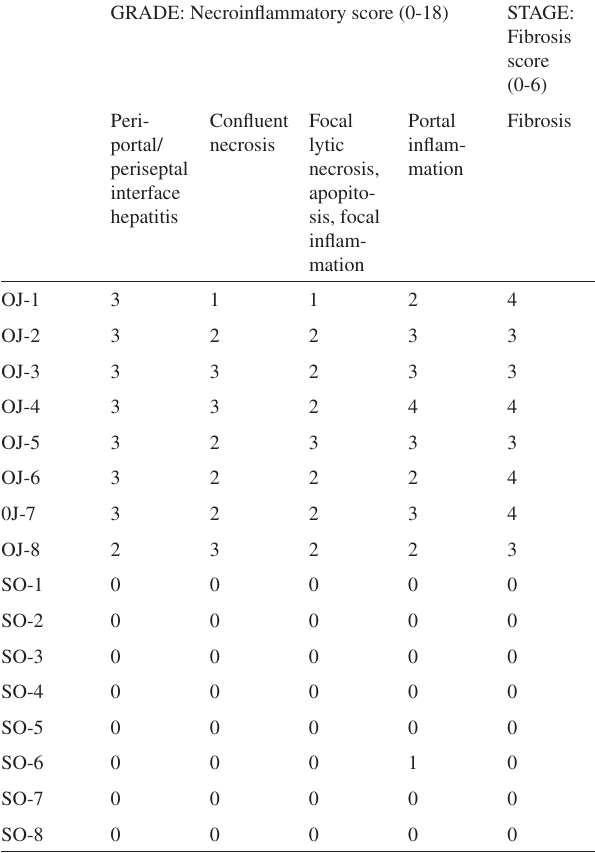
Table 3 - Histological activation index modified by Ishak et al. GRADE: Necroinflammatory score (0-18) STAGE: